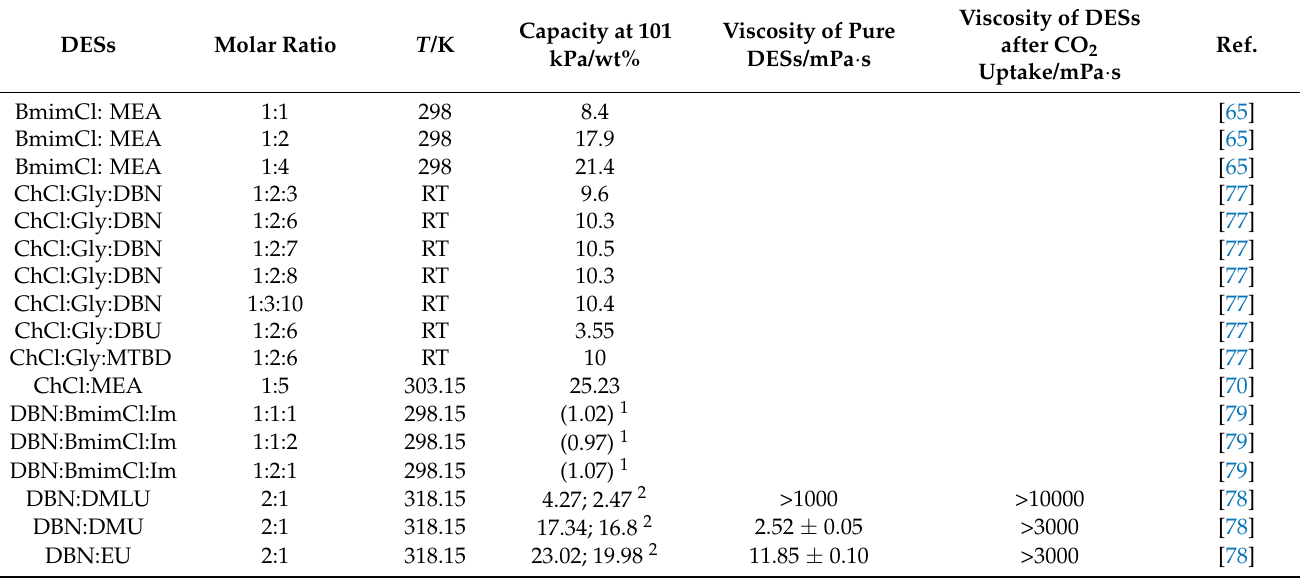
Table 4. CO 2 solubility in functionalized